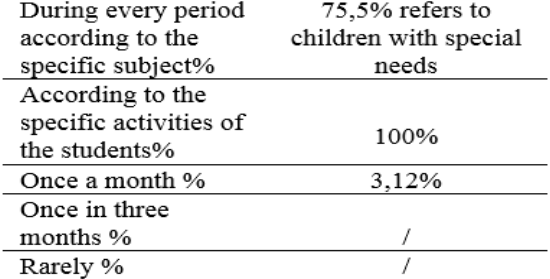
Table 1. The information is entered into the student’s portfolio